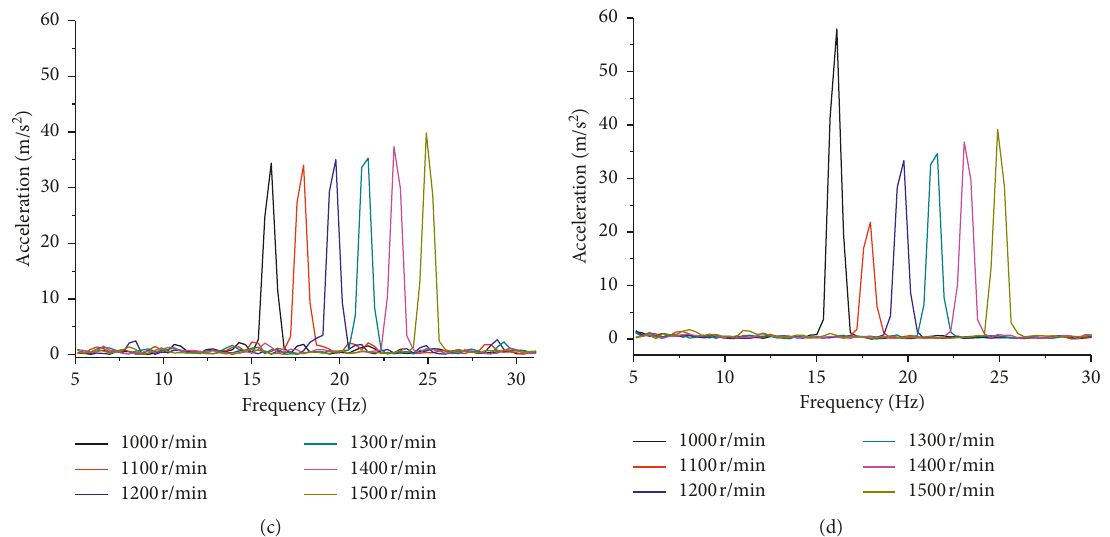
Figure 12: Vibration acceleration rotation frequency of the CFRP frame motor. (a) Sensor 1 on the base. (b) Sensor 2 on the cylinder shell. (c) Sensor 3 on the cylinder shell. (d) Sensor 4 on the cylinder shell.